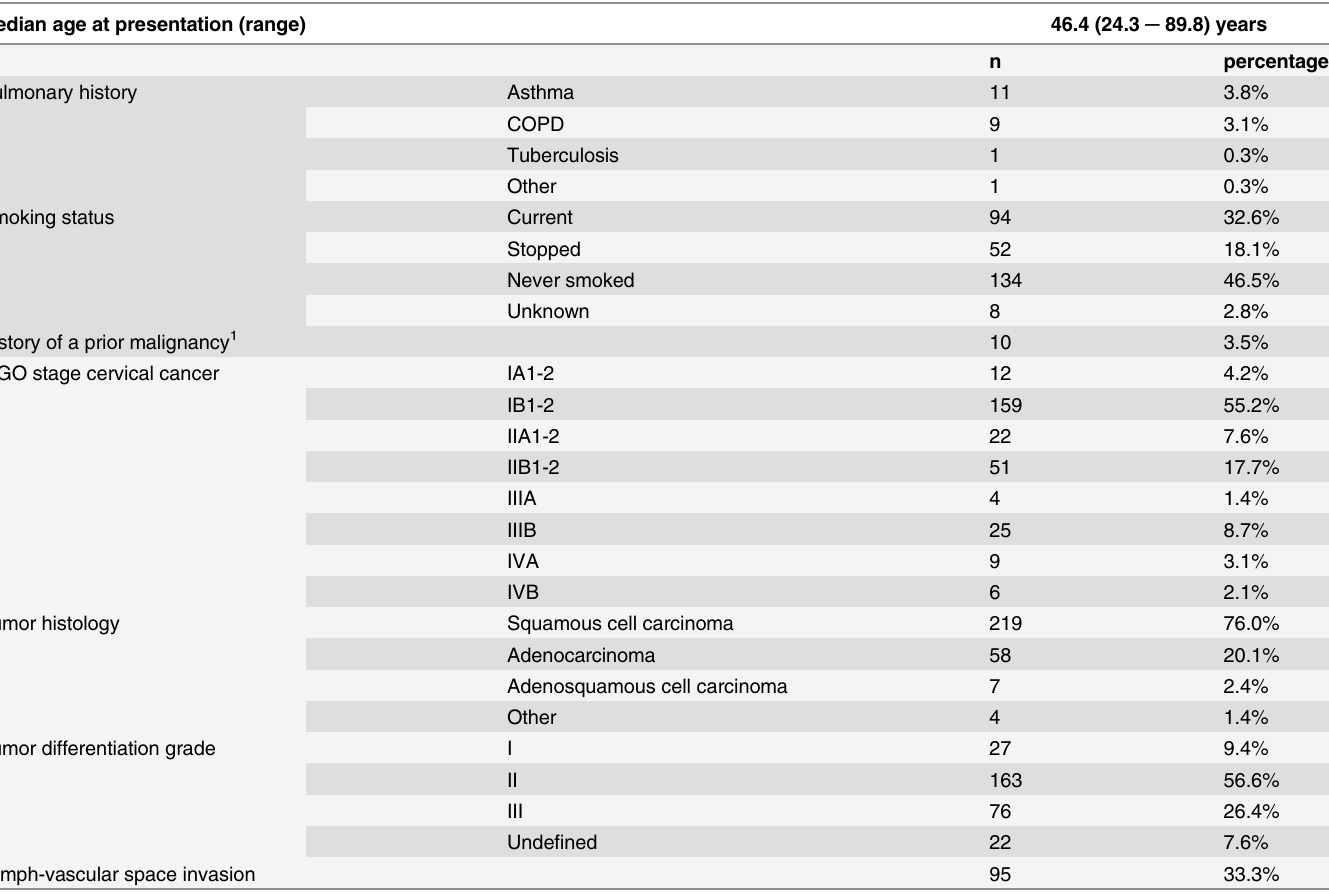
Table 1. Baseline characteristics of the study population (n = 288).